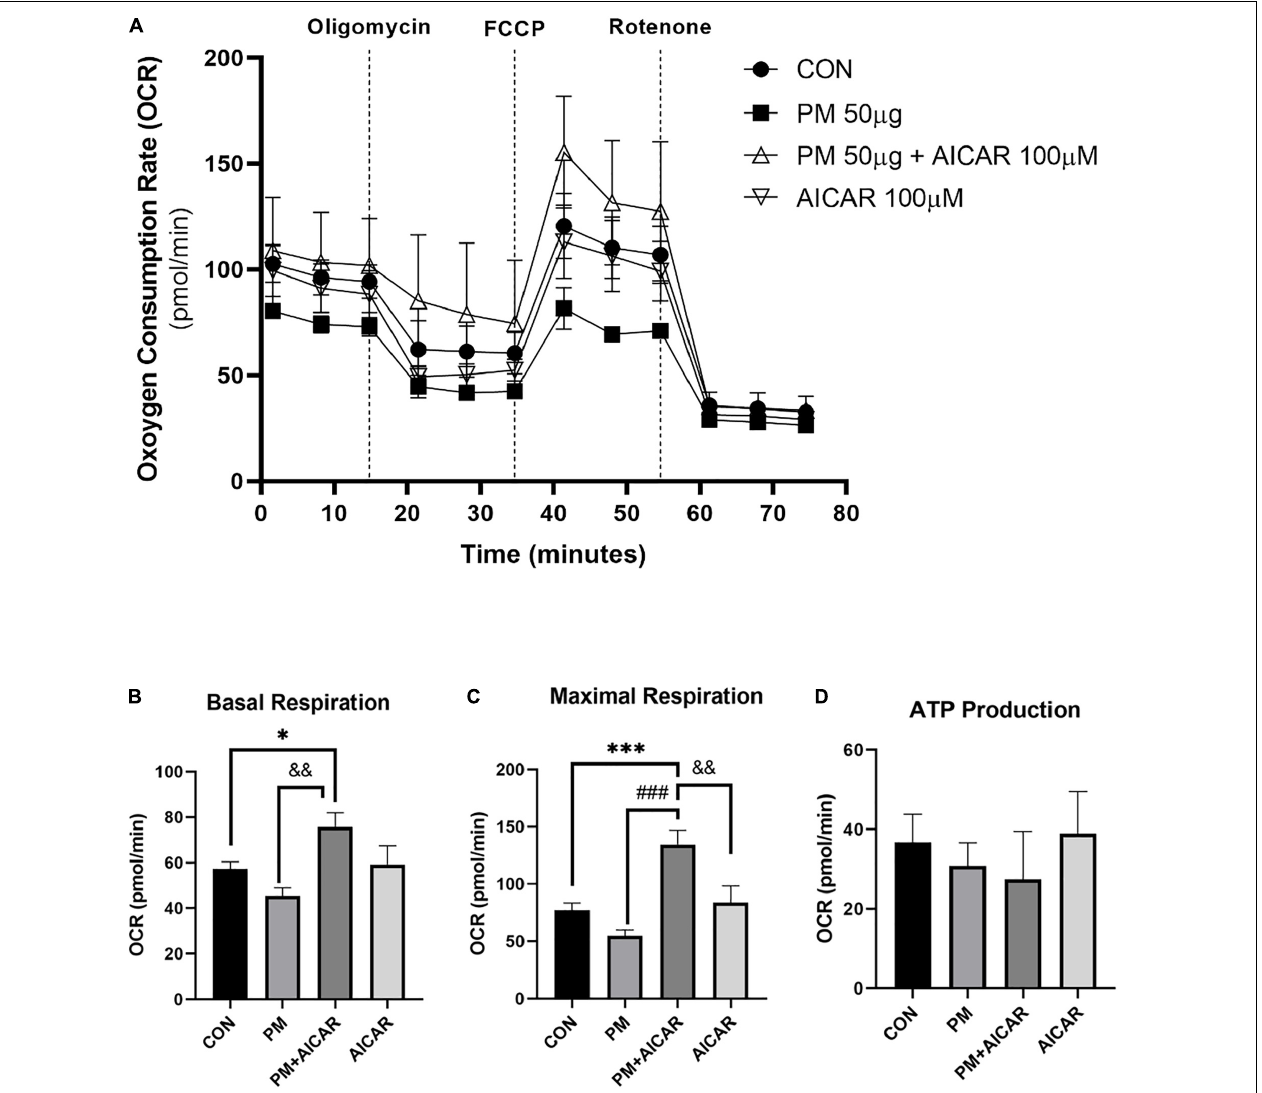
FIGURE 4 | Oxygen consumption rate (OCR) during PM exposure and AICAR treatment in A549 cells. (A) A549 cells were treated with oligomycin, FCCP, and rotenone/antimycin A to measure the effect of mitochondrial stress on OCR, upon PM exposure and AICAR treatment at 24 h incubation. The mitochondrial stress test was used to measure the bioenergetic parameters, (B) basal respiration, (C) maximal respiration, (D) adenosine triphosphate (ATP) production. Values are the means ± SEM. ∗ P < 0.05 vs. CON, ∗∗∗ P < 0.001 vs. CON, ### P < 0.001 vs. PM, && P < 0.01 vs.